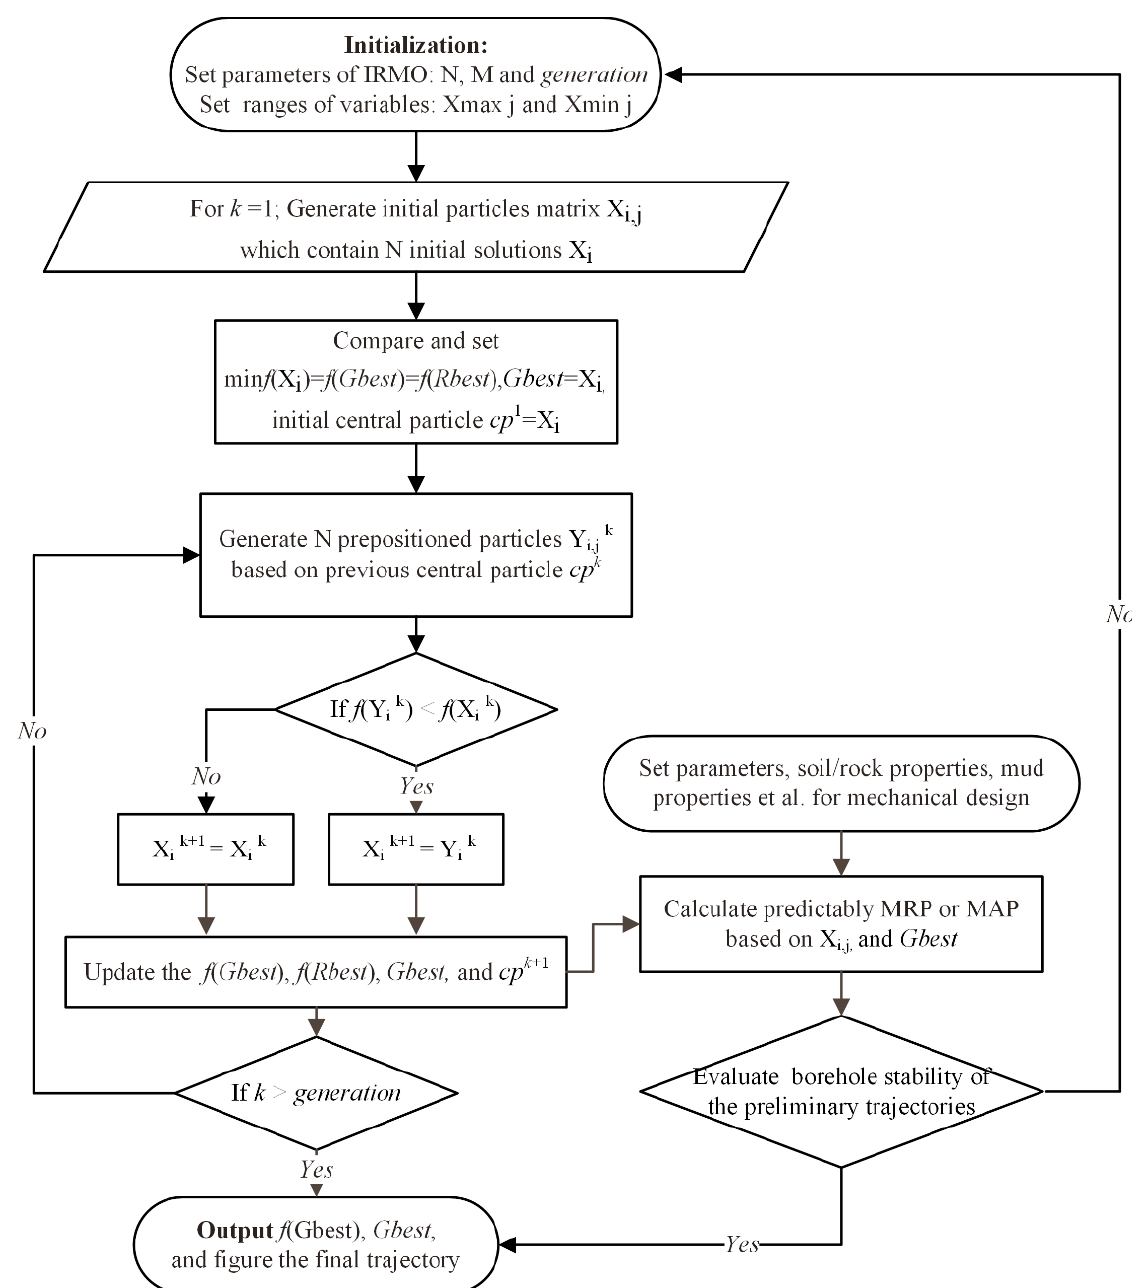
Figure 5. The implementation of the IRMO algorithm.